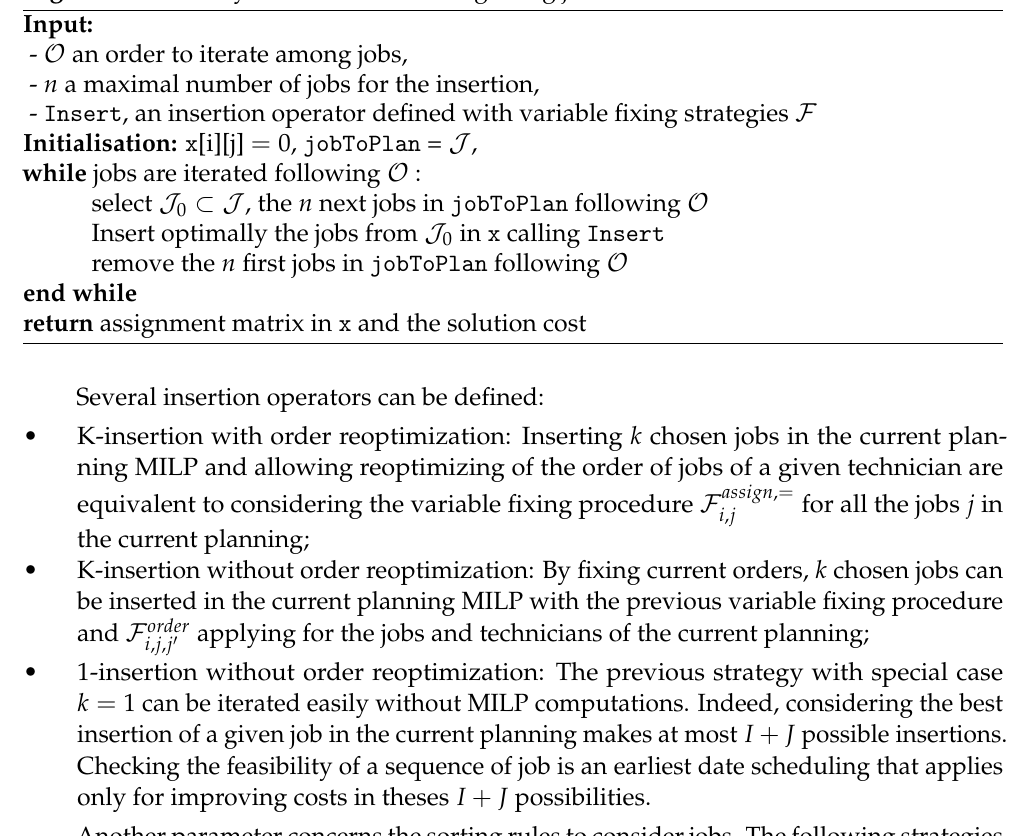
Algorithm 2 Greedy FO heuristic iterating along